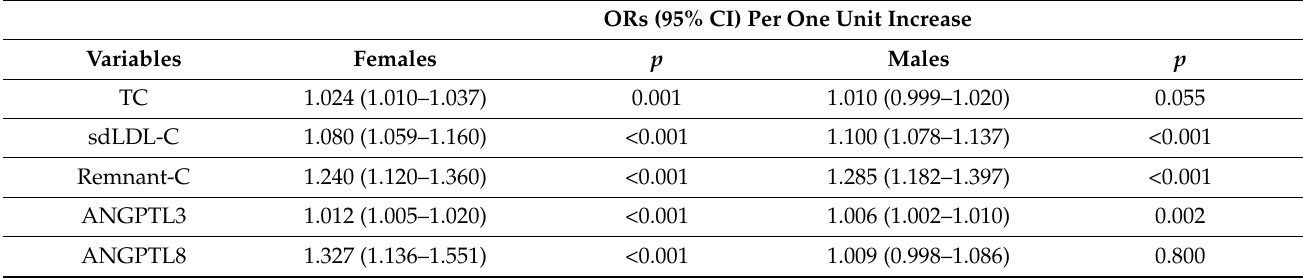
Table 5. Multivariable logistic regression analyses for predictors of hypertriglyceridemia stratified by gender. ORs (95% CI) Per One Unit